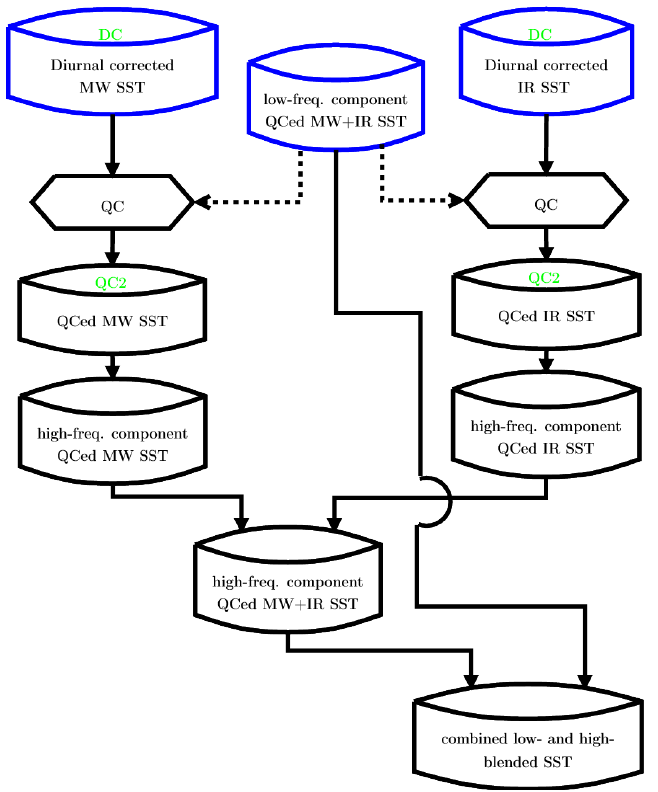
Figure 4. Same as Figure 3, but for the high-frequency part and combined low- and high-frequency parts used in this study. Data storage indicated by blue color is derived from the previous step (Figure